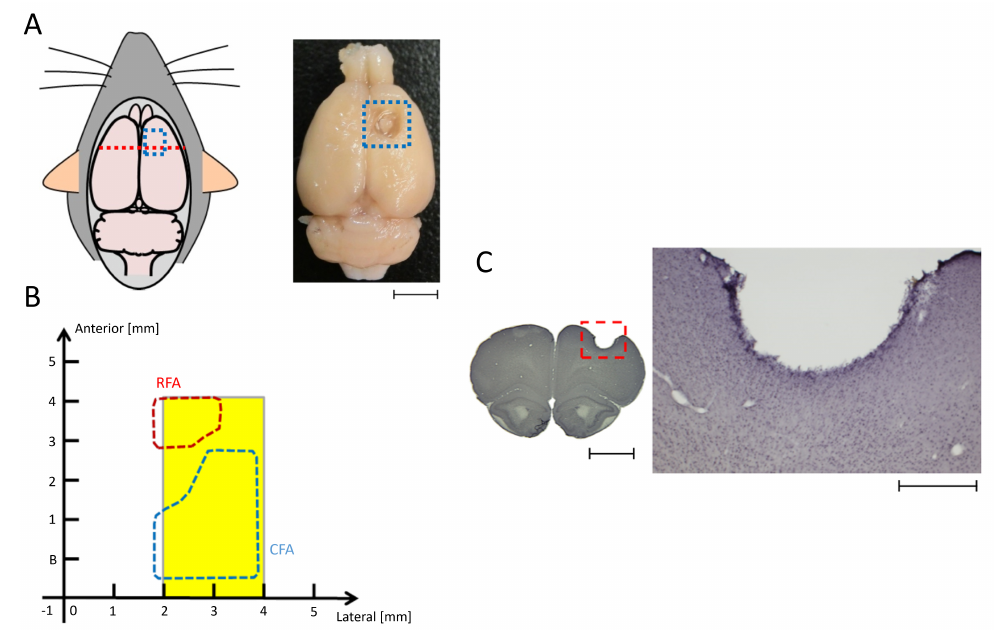
Fig. 4. Schematic diagram of the damaged area and the state of the damage. (A) It is a rat brain from above. The red dotted line in the figure indicates the position of the bregma. The blue dotted line in the figure was damaged area. The scale bars indicate 5 mm. (B) It is an enlarged view of the square part of the blue dotted line in the figure of (A). The vertical axis is 0 for bregma (B) and positive for the anterior, and the horizontal axis is 0 for the median and positive for the outer (Lateral). The forelimb motor cortex of rats has Rostral Forelimb Area (RFA) and Caudal Forelimb Area (CFA). The damage this time was set to the yellow area in the figure surrounding these two areas. (C) A Nissl stained section shows the lesion induced by the cortical aspiration. A part with a red rectangle was enlarged to the right. The scale bars indicate 2 mm and 500 µ m, respectively.